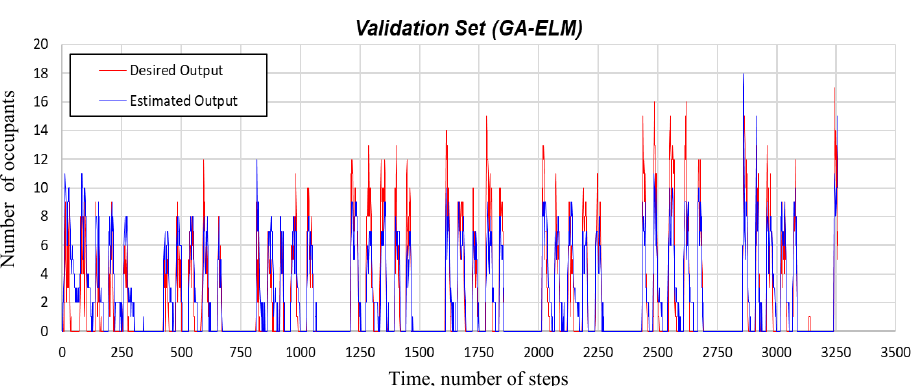
Fig. 7 . GA - ELM model occupancy prediction results based on CO 2